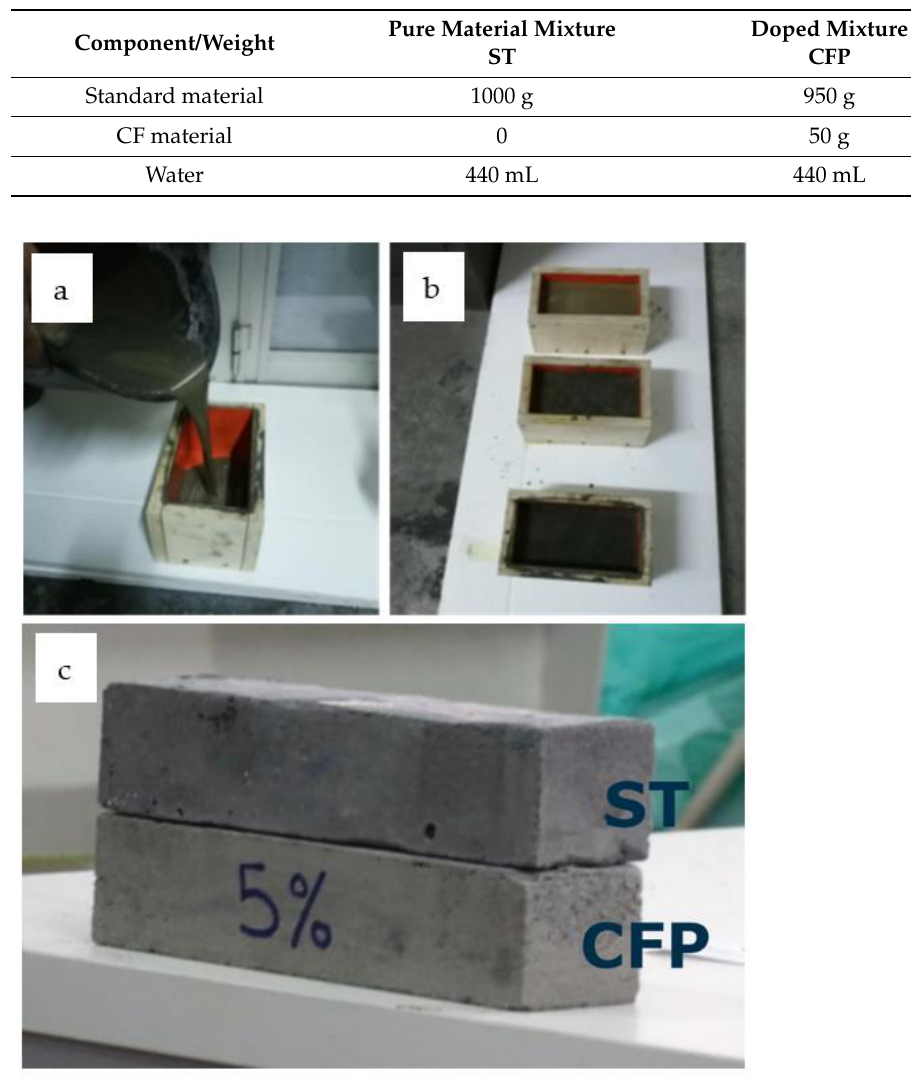
Figure 2. ( a ) Uniaxial ( Rc ), ( b ) flexural compressive ( Rf ) strength tests and ( c ) thermal conductivity tests on the standard and doped (ST with 5% of CFP) bentonitic grout samples. Concerning the second step, experimental determinations of thermal conductivity have been conducted in collaboration with the Technical Physics Lab of the University of Catania by means of a heat flow meter. The measurement process has been performed with a non-stationary hot wire method according to the standards of ASTM E 1530 [25]. The test lasted 180 s (60 s on average) after the heating wire reached the operative temper- ature condition (temperature <20 °C in 45 min). During the heat transfer process from the instrument to the sample, the temperature increase is lower than 20 °C without changes in the material properties during tests [14,26,27]. The use of high thermal conductivity